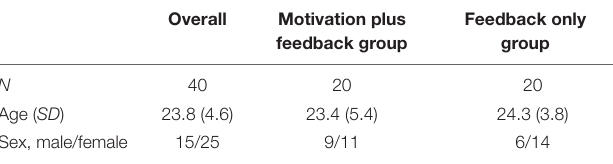
TABLE 1 | Participant